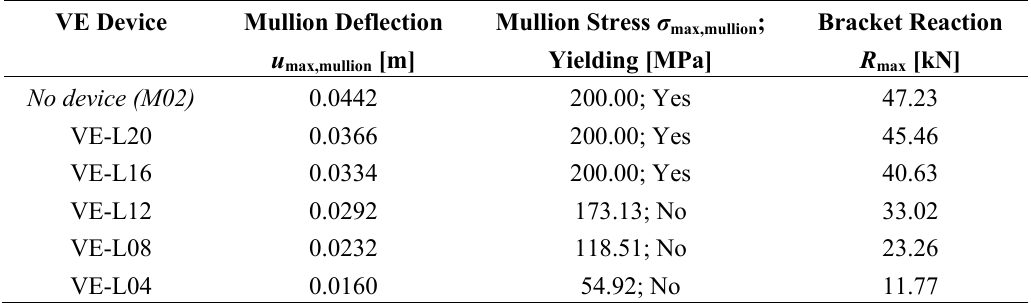
Table 4. Numerical results of parametric analyses (ABAQUS). Mullions and